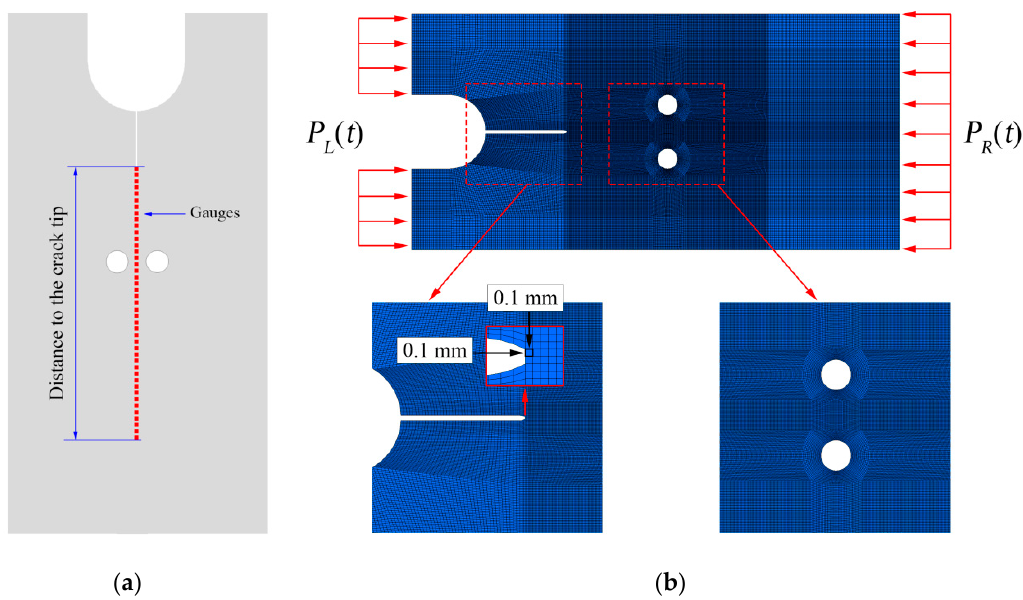
Figure 10. Numerical (AUTODYN) simulation specimen. ( a ) Location of gauge points on the specimen. ( b ) Mesh of the specimen.